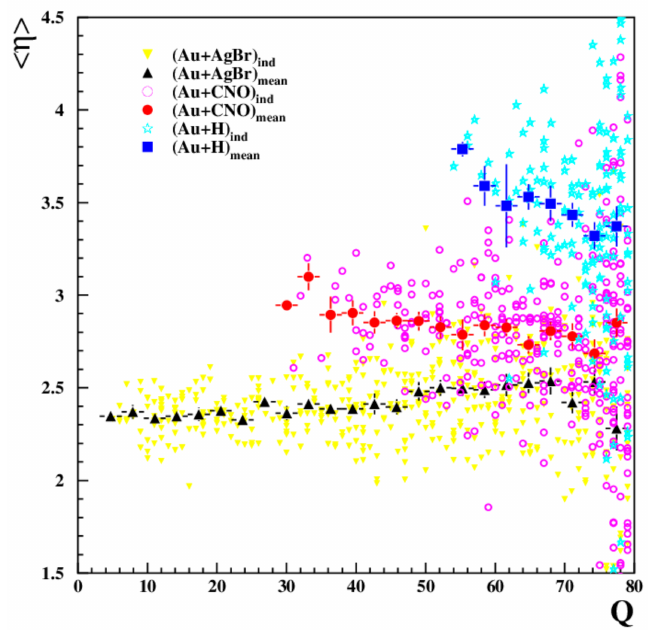
Figure 5. Average values of the pseudo-rapidity distribution of s -particles as a function of the total charge of the projectile-nucleus Au-197 with heavy and light emulsion